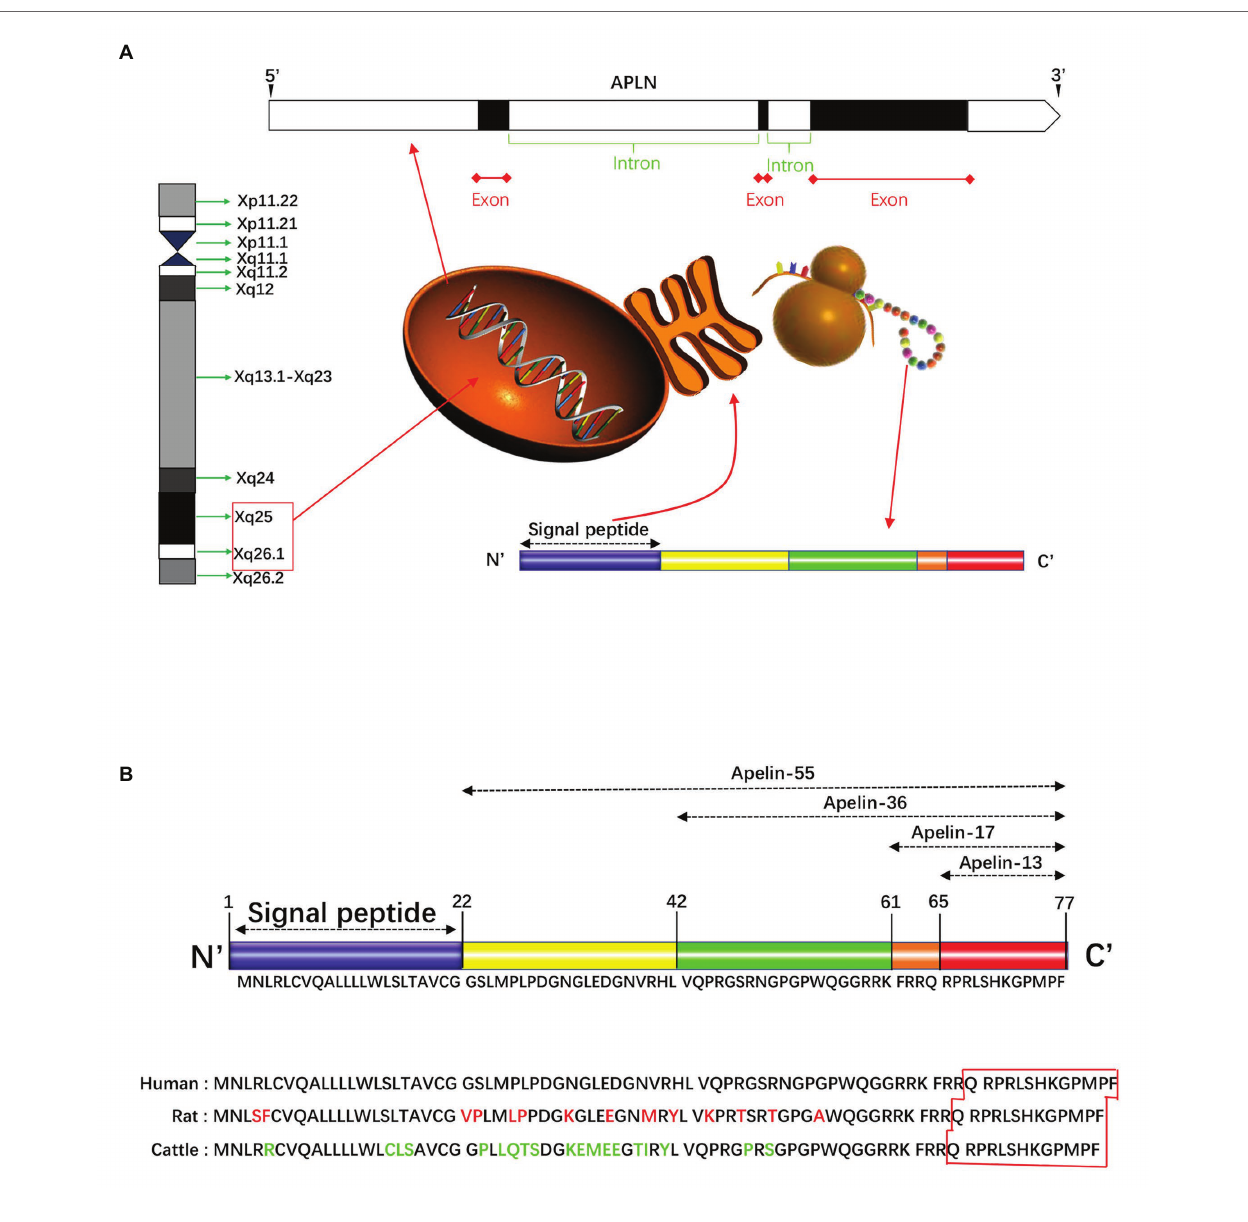
FIGURE 1 | Schematically presentation of apelin in gene and protein. (A) The human apelin gene is located in the chromosome Xq25-26.1. Its gene sequence contains three exons and two introns. The apelin gene encodes a 77-amino acid propeptide, preapelin, which has a hydrophobic N-terminal region and a C-terminal. The N-terminal is a signal sequence, and the C-terminal has a variety of biological activities and specific regions that bind to apelin receptor (APJ). (B) The N-terminal residue of preapelin is modified by endopeptidase to form pro-apelin-55, which is subsequently cleaved into various forms, including apelin-13, apelin-17, and apelin-36. The results of the cohort study of the amino acid sequences of cattle, humans, and rats showed that the 17 amino acids at the C-terminal were extremely conserved. Apelin-13 is the shortest active fragment present in organisms. Apelin-36 has 86–100% structural homology between human, cattle, and rat, while the C-terminal sequence homology up to